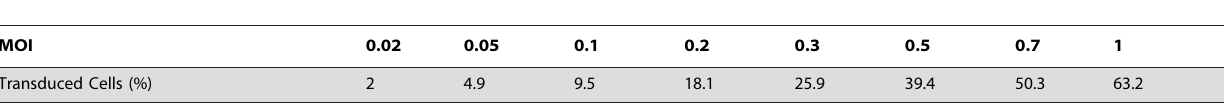
Table 1. Percentage of transduced cells at a given MOI.